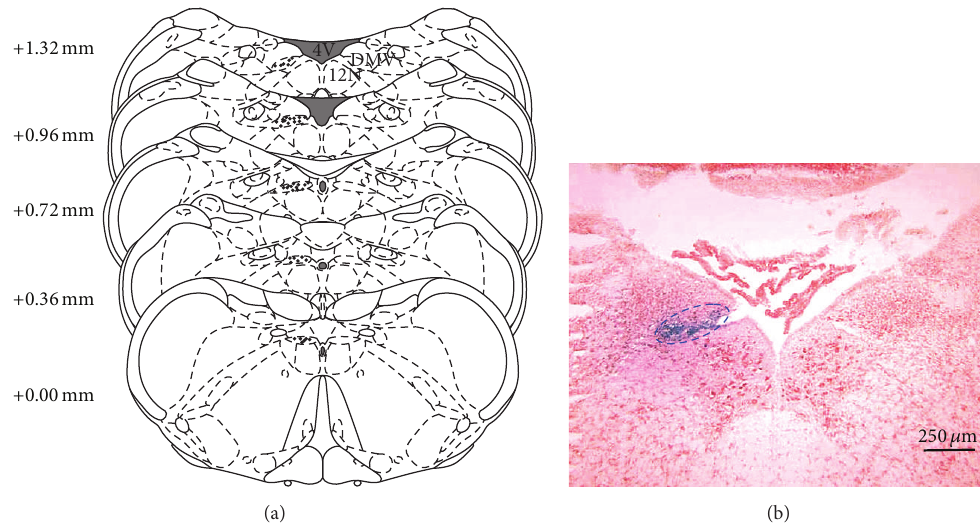
Figure 1: Histological sites of micropipette tips in the DMV of the rat. Reconstruction detailing microinjection sites of chemical into the DMV in the brain atlas, with the dots indicating the micropipette tips. Numbers indicate distance from the obex in the anteroposterior plane. 4V: the 4th ventricle, 12N: the hypoglossal nucleus (a). Representative brain stem section showing the position of DMV, with ellipse and blue macula indicating DMV (b).